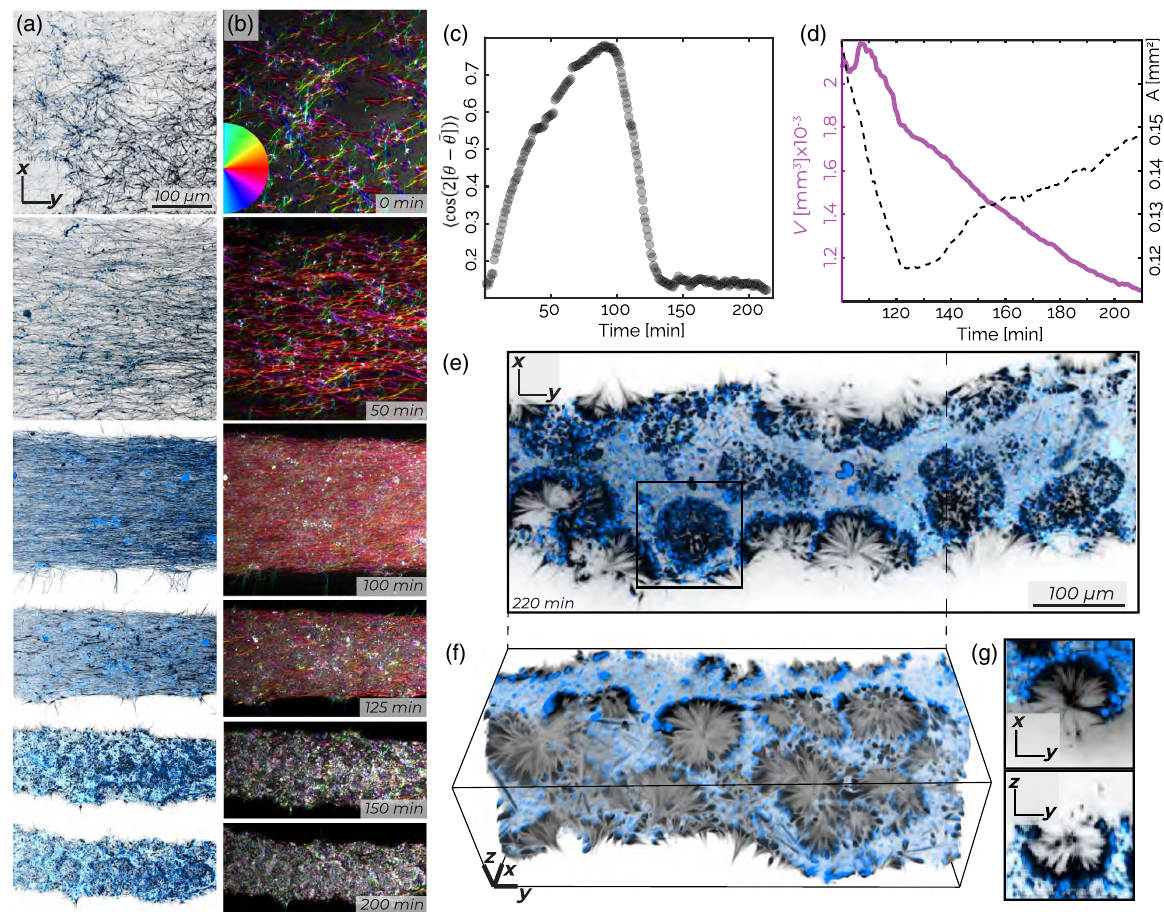
FIG. 4. Contracting gel: Contractions yield nematic alignment and surface roughening. (a) z -projected images demonstrate that decreasing network volume leads to increasing nematic alignment. (b) z projection of the microtubule nematic order. Hue indicates the nematic director indicated by the color wheel, while intensity indicates coherency (Supplemental Material [32]). (c) The microtubule nematic order parameter increases during contraction and then decreases during roughening. (d) The contracting network ’ s volume (solid purple line) decreases continuously. Its surface area (dashed black line) initially decreases but then increases. (e) A 10 μ m z projection of the material after surface roughening generates spherical cavities. (f) A cropped 3D projection highlights the invaginated structure of the microtubule network. (g) x - y and z - y show a hemispherical cavity. The sample is composed of 10 μ M tubulin (black) and 200 nM kinesin